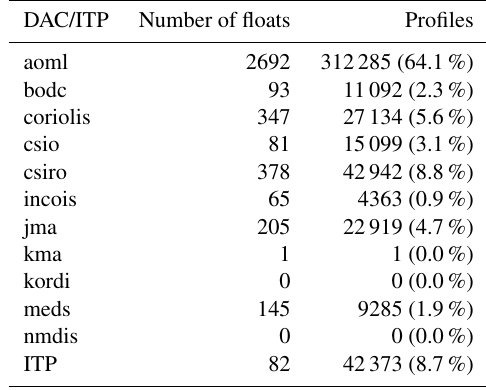
Table 1. Number of floats and profiles in the global dataset. Profiles taken with Argo floats are categorized by the Data Assembly Centre (DAC). Profiles taken with Ice-Tethered Profilers are categorized as ITP. The percentage between brackets indicates the relative contri- bution to the total number of profiles in the global dataset (487493 profiles). More details on abbreviations of DAC can be found in Argo